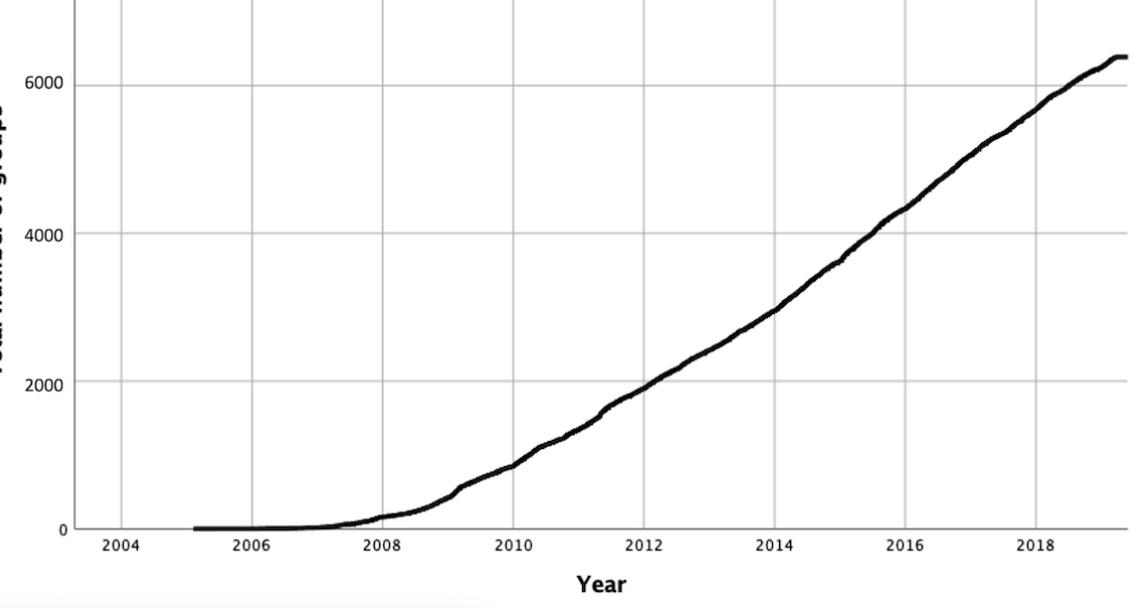
Disease-Describing